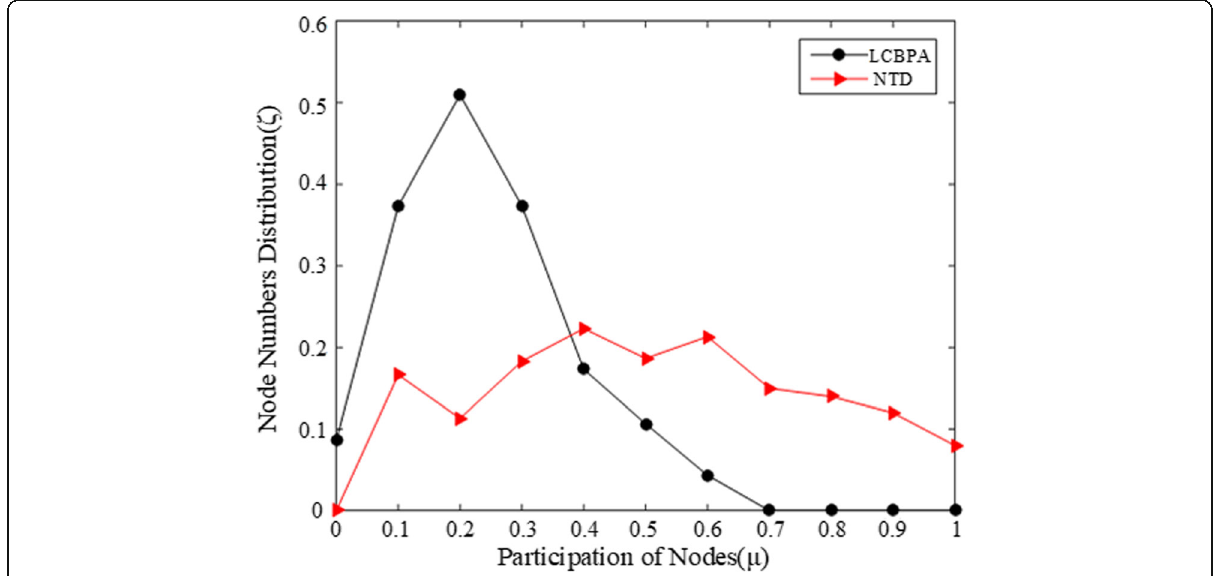
Fig. 8 Comparison of node participation equality of LCBPA and NTD when k = 20, the nodes number α = 0.5, N =